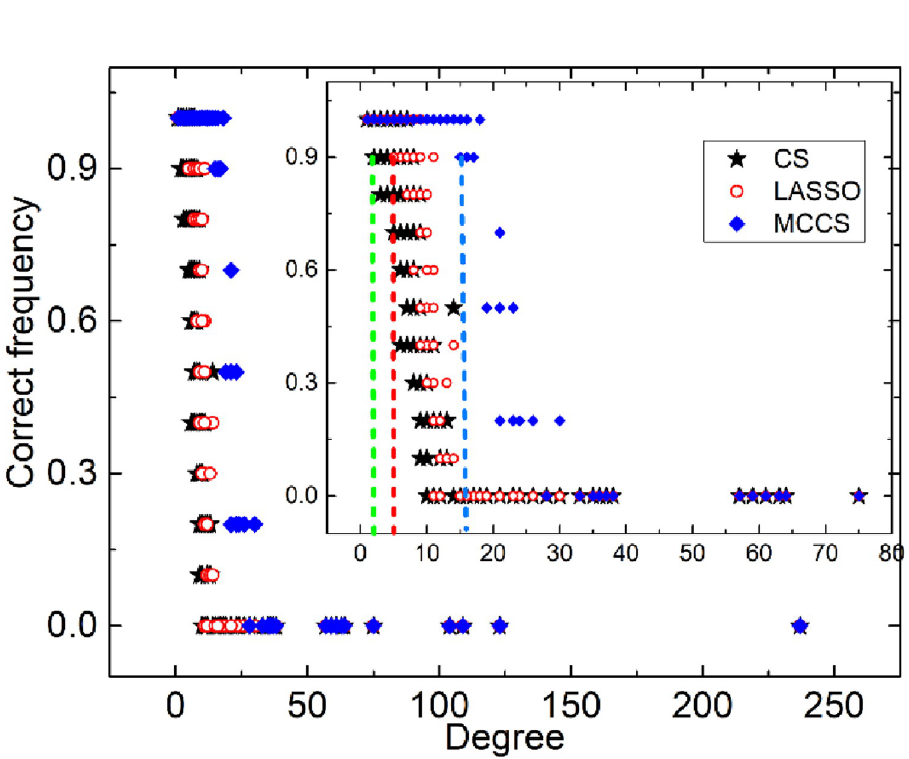
Fig 7. The completely correct frequency in 10 experiments on the elegans network under 50 samples.